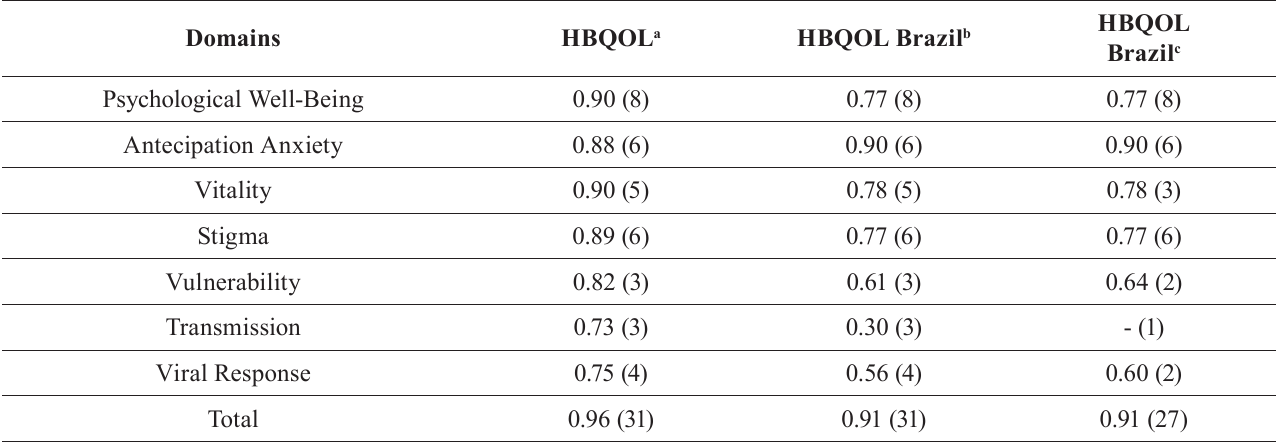
TABLE III - Internal consistency of HBQOL domains and their cross-culturally adapted version for Brazil before and after AF